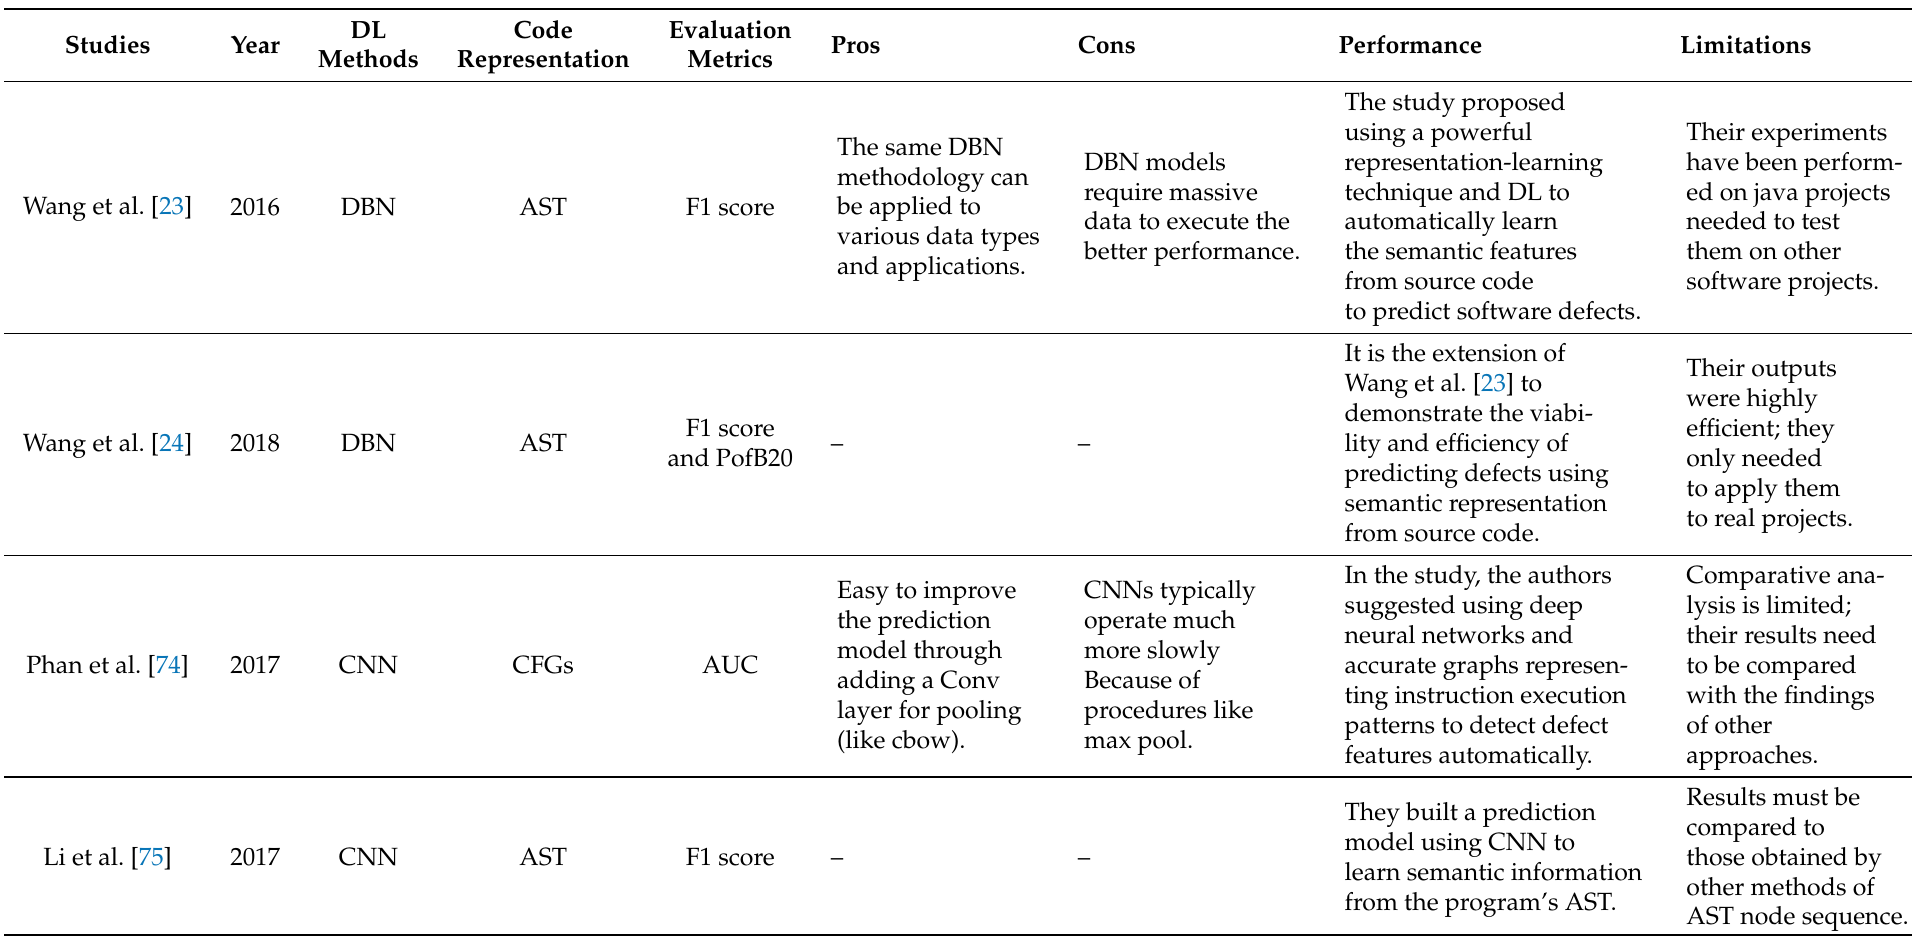
Table 5. Performance analysis DL techniques applied to semantic feature-based SDP